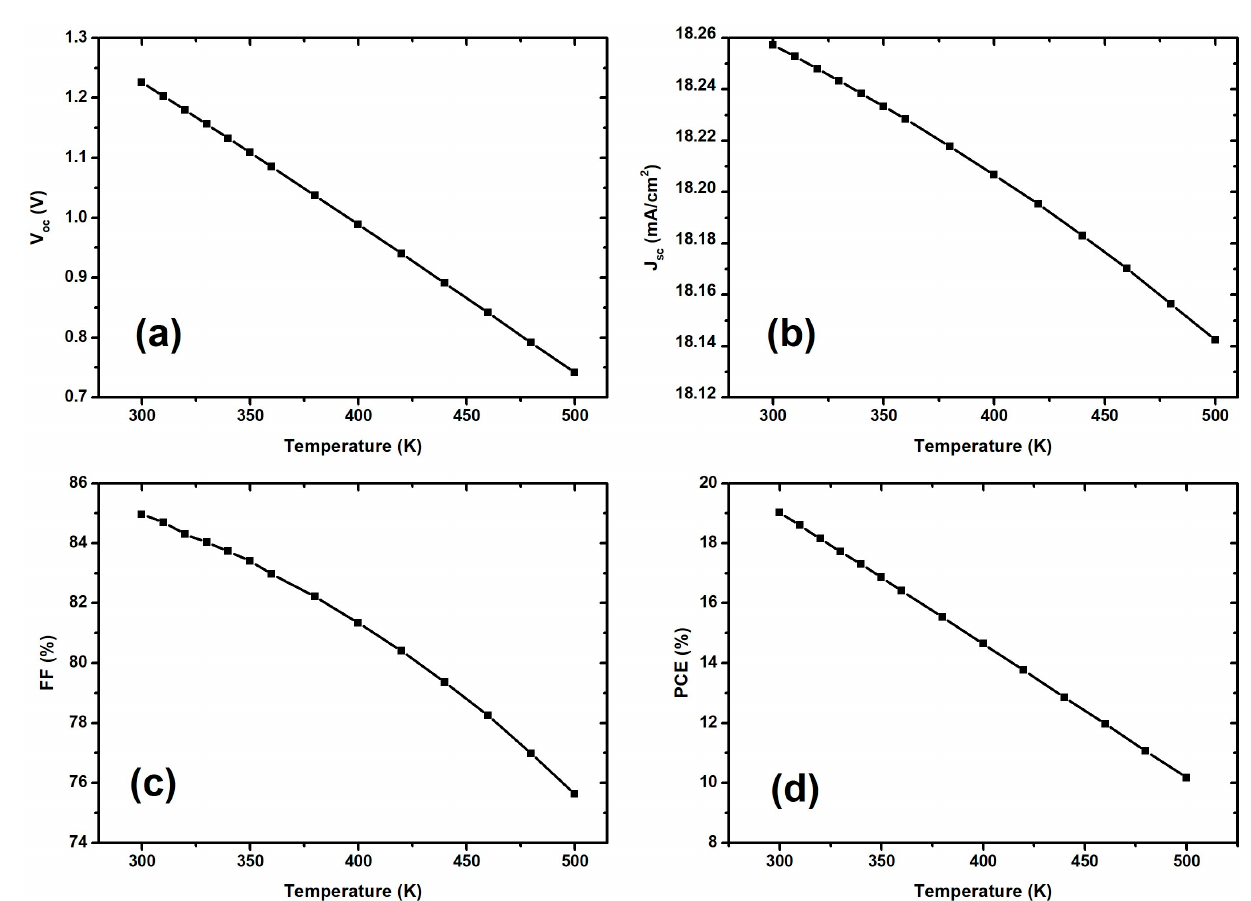
Figure 12 . Impact of temperature on C 2 N-based solar cell performance. Figure 12. Impact of temperature on C 2 N-based solar cell